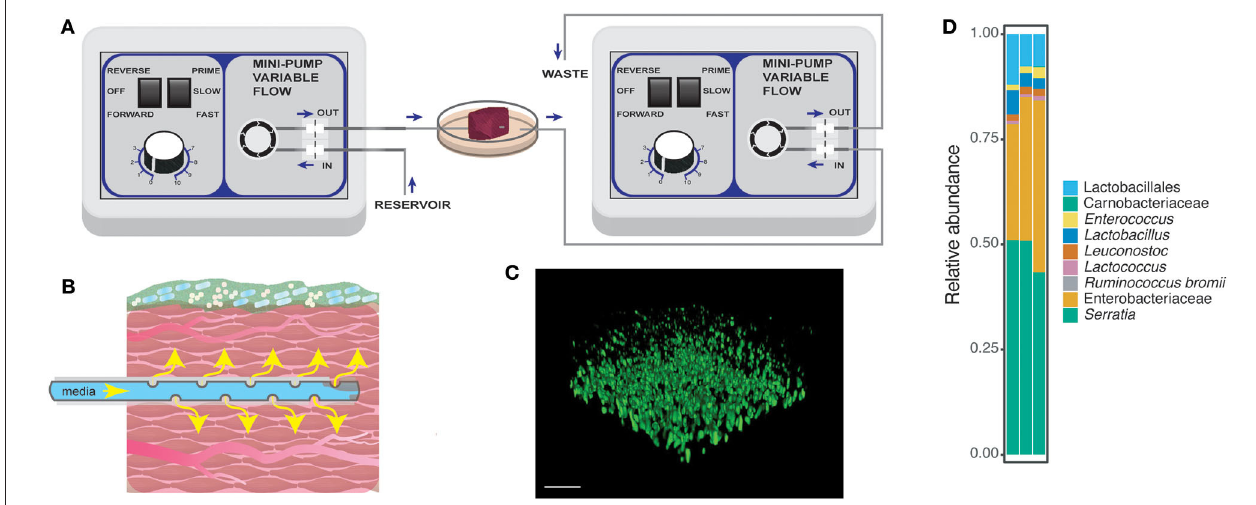
FIGURE 1 | Schematic for the perfusion wound meat model. (A) Perfusion setup with two flow regulators as described in the section Methods . Briefly, the purpose of each of the flow regulators was to introduce flow of nutrients through the tissue and to remove excess media waste. Perforated tubing was threaded through the tissue to provide nutrients to the surrounding tissue. The end of the tube was capped, allowing the media to be released only through the pores on the tubing in the meat [also displayed in (B) ]. (B) A closer look at the tissue with flow and microbial community growth from the perfusion model. (C) A confocal image of the PA14- yfp growing on the surface of the tissue. The image was taken from the static model after 24h of growth. Bar = 20 µ m. The tissue had a native microbial community, meat background (MB control), whose bacterial members are displayed in (D) . (D) Amplicon sequencing was performed on MB control communities harvested from three replicates from the static model.